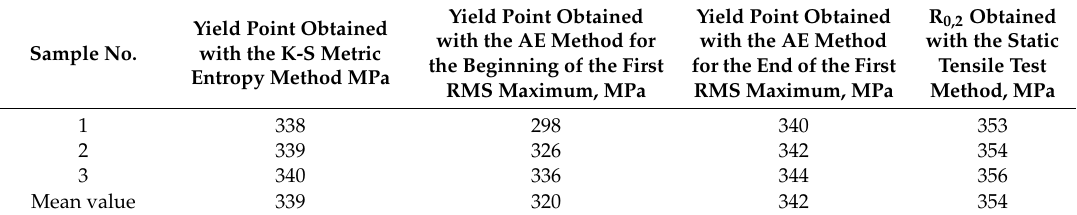
Table 4. A list of yield point values obtained with the K-S metric entropy method, e ff ective RMS signal, the AE method and based on the static tensile test diagram for samples made of EN AW 7020 aluminum